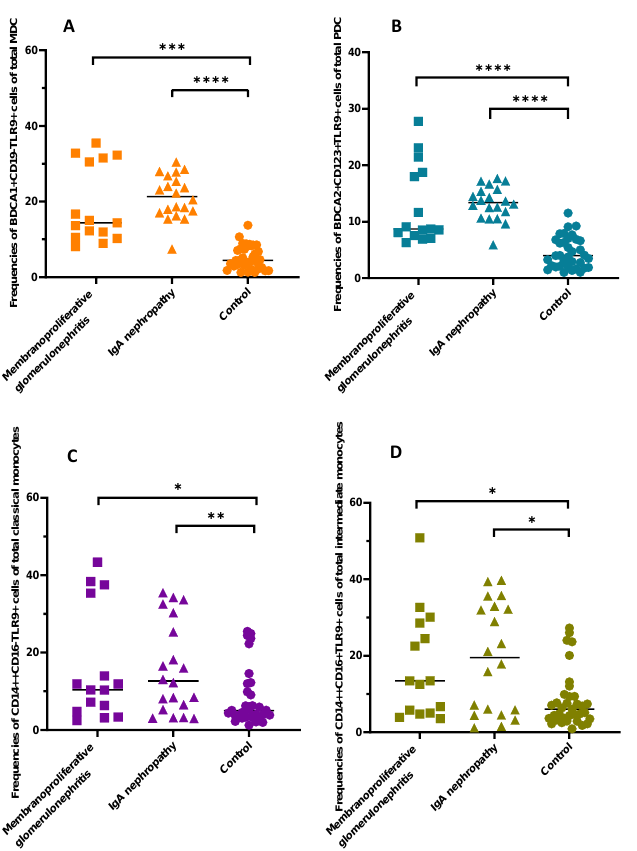
Figure 1. Frequencies of the DCs and monocytes expressing TLR9 antigen in the patients and con- trols. ( A ) Frequencies of BDCA1+CD19 − TLR9+ cells of total mDC; ( B ) frequencies of BDCA2+CD123+TLR9+ cells of total pDC; ( C ) frequencies of CD14++CD16-TLR9+ cells of total classical monocytes; ( D ) frequencies of CD14++CD16+TLR9+ cells of total intermediate monocytes. (*, p<0.05, **; p<0.01, ***; p<0.001; ****, p<0.0001)